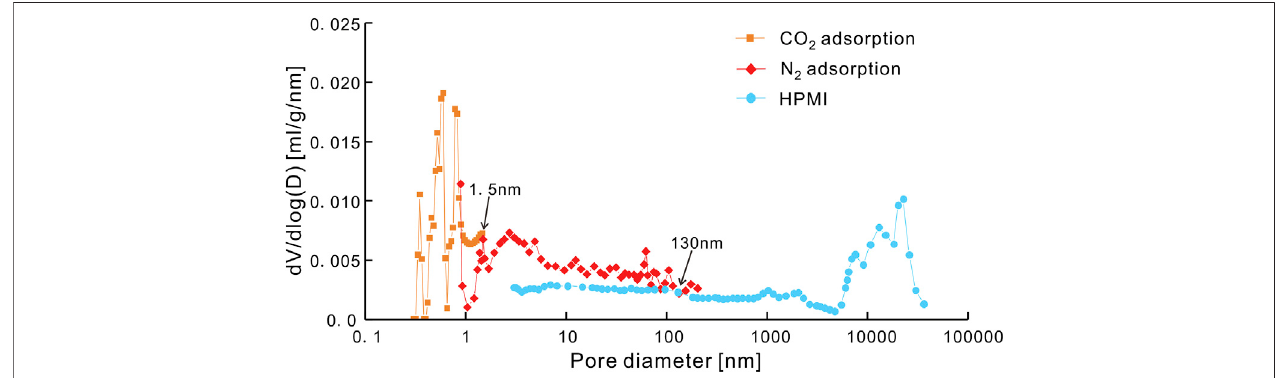
FIGURE 7 | Pore size distribution derived from CO 2 GA, N 2 GA and HPMI for the Longmaxi Formation shales in the northern Guizhou area.